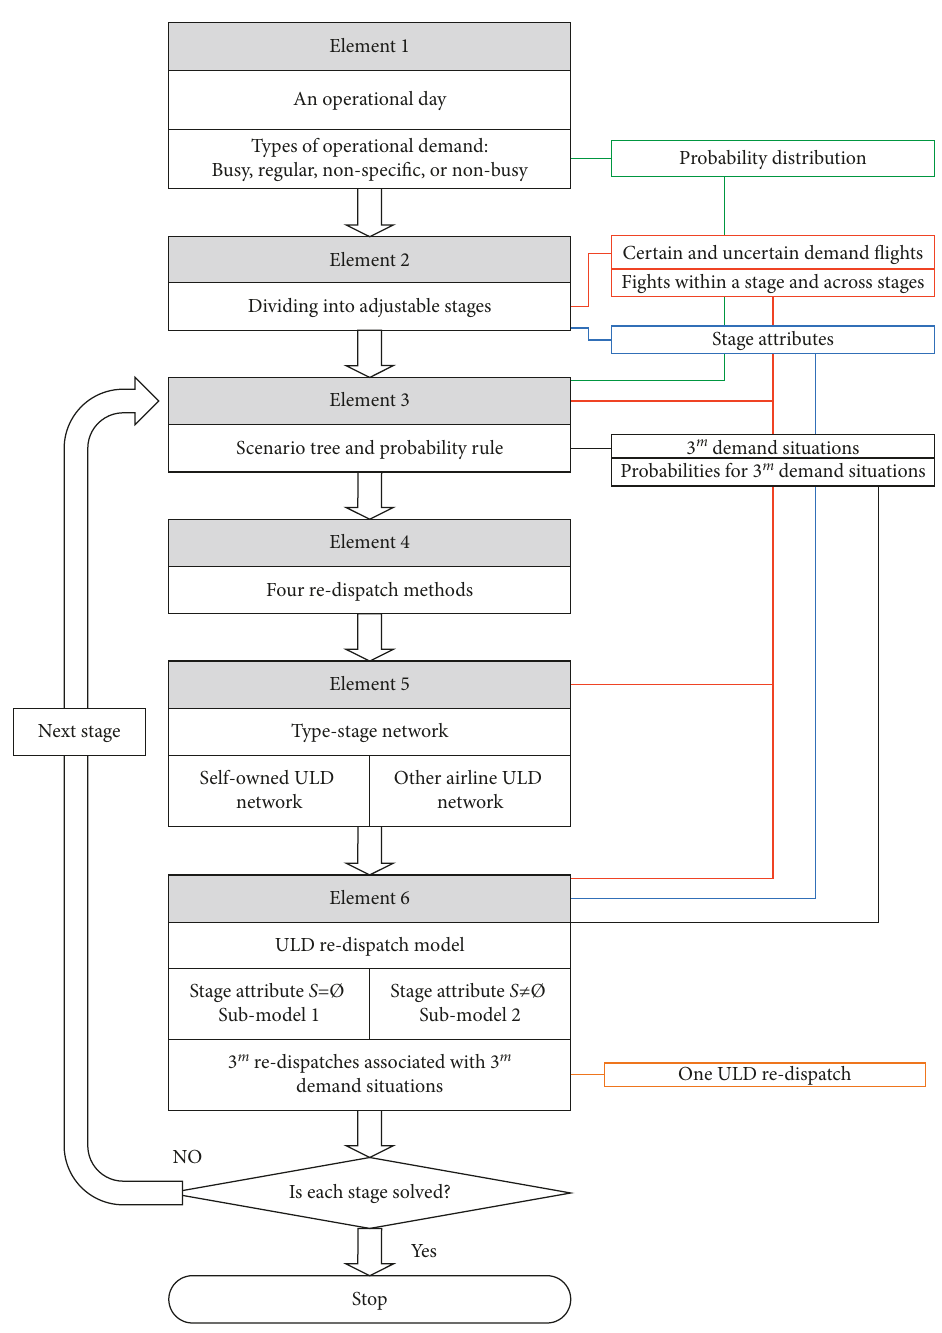
Figure 10: Entire procedure for the hybrid framework for a day.